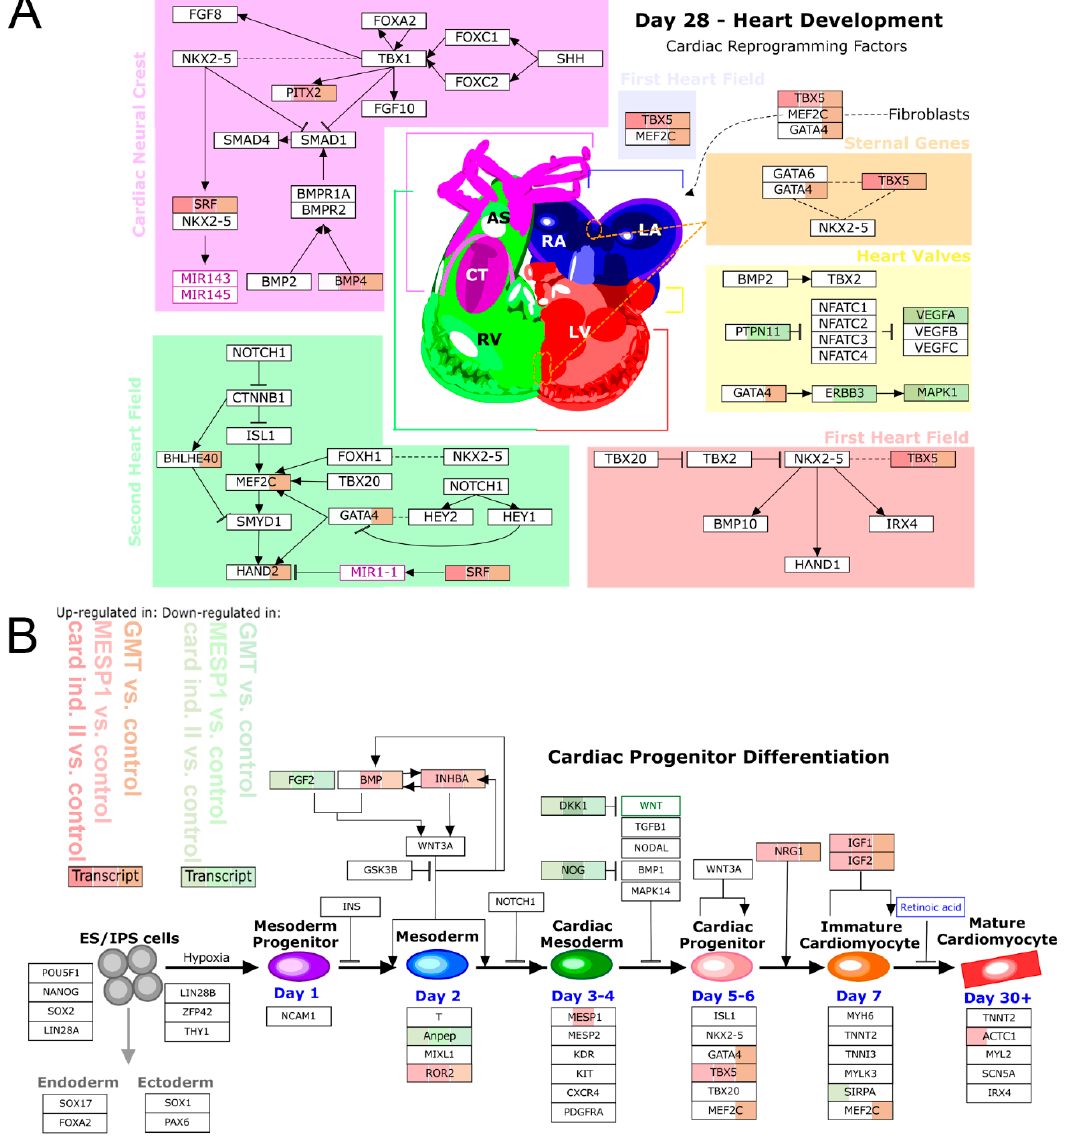
Figure 6. The impact of reprogramming on cardiac-differentiation pathways. Up-regulated and down-regulated transcripts of respective programming conditions are labelled in red or green color. ( B ) cardiac progenitor di ff erentiation) was mainly found in GMT reprogrammed cells, followed by MESP1 treatment and cardiac induction medium II. Key cardiac transcription factors and